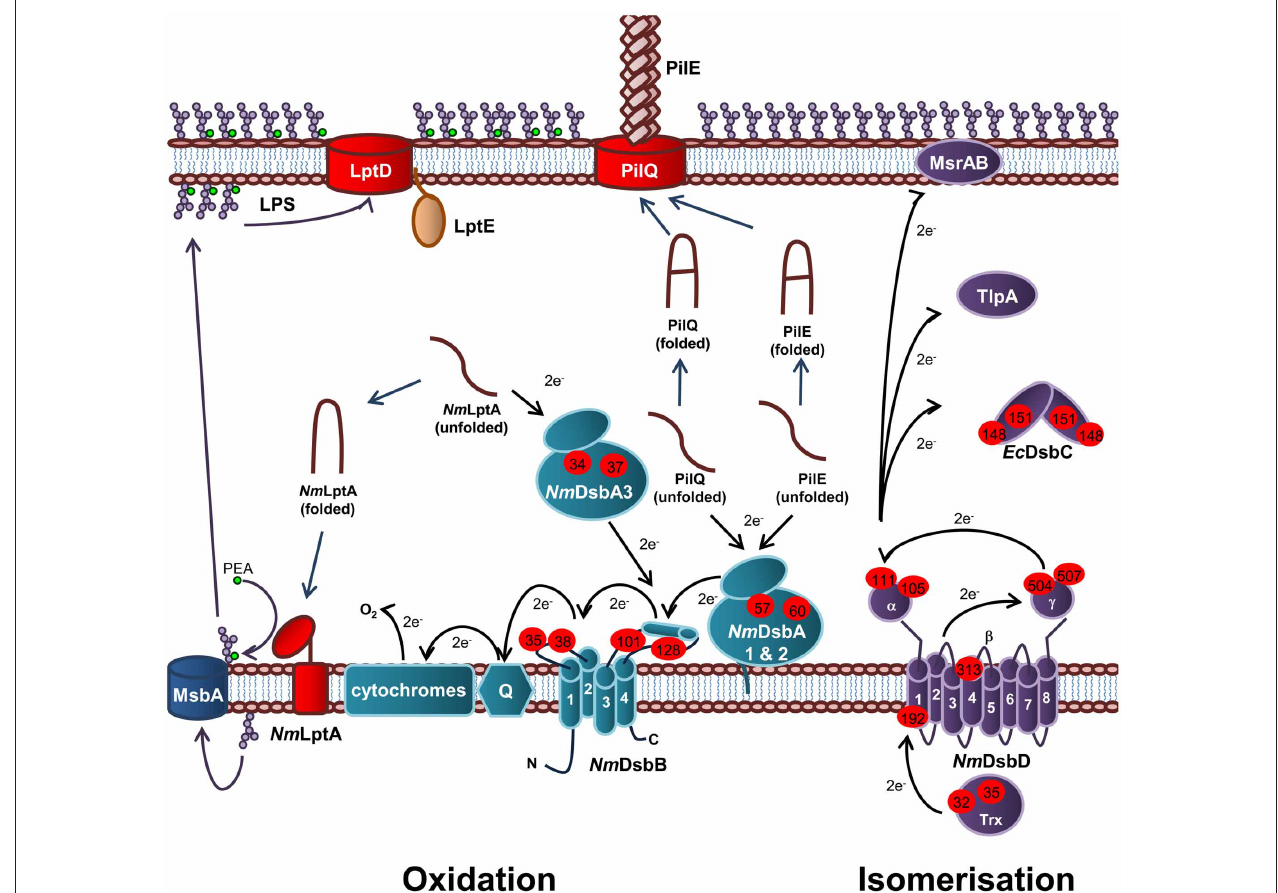
FIGURE 5 | Oxidation and isomerization pathways of periplasmic protein folding in N. meningitidis and contribution to virulence. Oxidation pathway: The oxidoreductases Nm DsbA1 and Nm DsbA2 and IM bound lipoproteinsthat catalyze disulfide bondformation in the PilE and PilQ subunits of the Type IV secretion system. The soluble preiplasmic oxidoreductase Nm DsbA3 catalyzes disulfide bond formation in the periplasmic domain of the PEA transferase Nm LptA, which is responsible for PEA modification of LOS lipid A upon translocation across the IM by the transporter, MsbA, prior to transport across the periplasm and integration into the OM by LptD and LptE. Nm DsbA1, Nm DsbA2, and Nm DsbA3 are re-oxidized by the IM bound